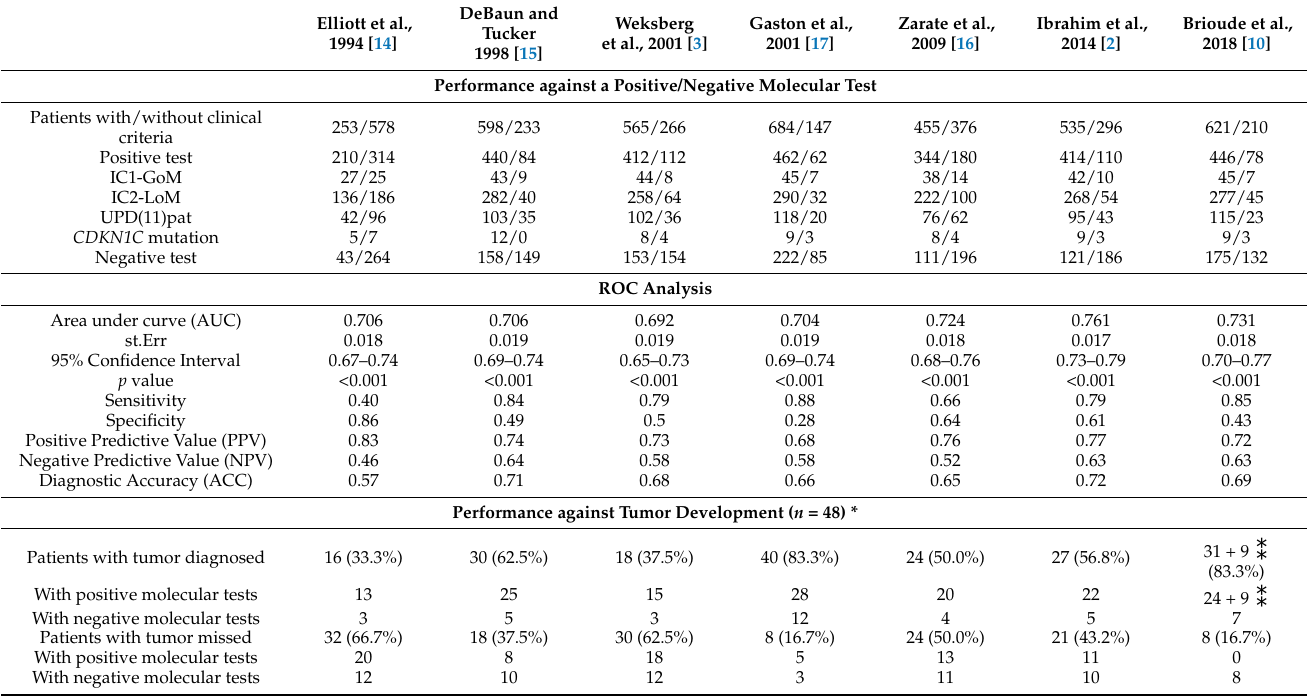
Table 4. Performance metrics and characteristics of the several scoring systems for BWSp proposed over time evaluated against the outcomes a) molecular test and b) cancer development: area under the curve (AUC), standard error (st.Err), 95% Confidence Interval (95%CI), p -value, sensitivity (Se), specificity (Sp), positive and negative predictive value (PPV, NPV), and accuracy